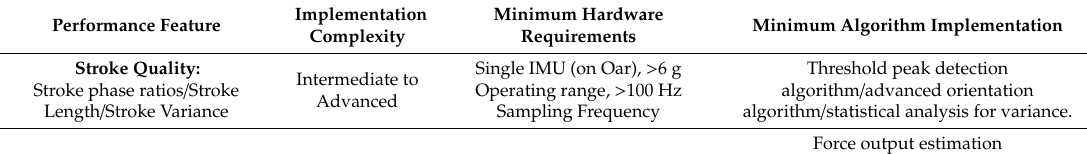
Table 7. Reference guide for technology selection when conducting future research.